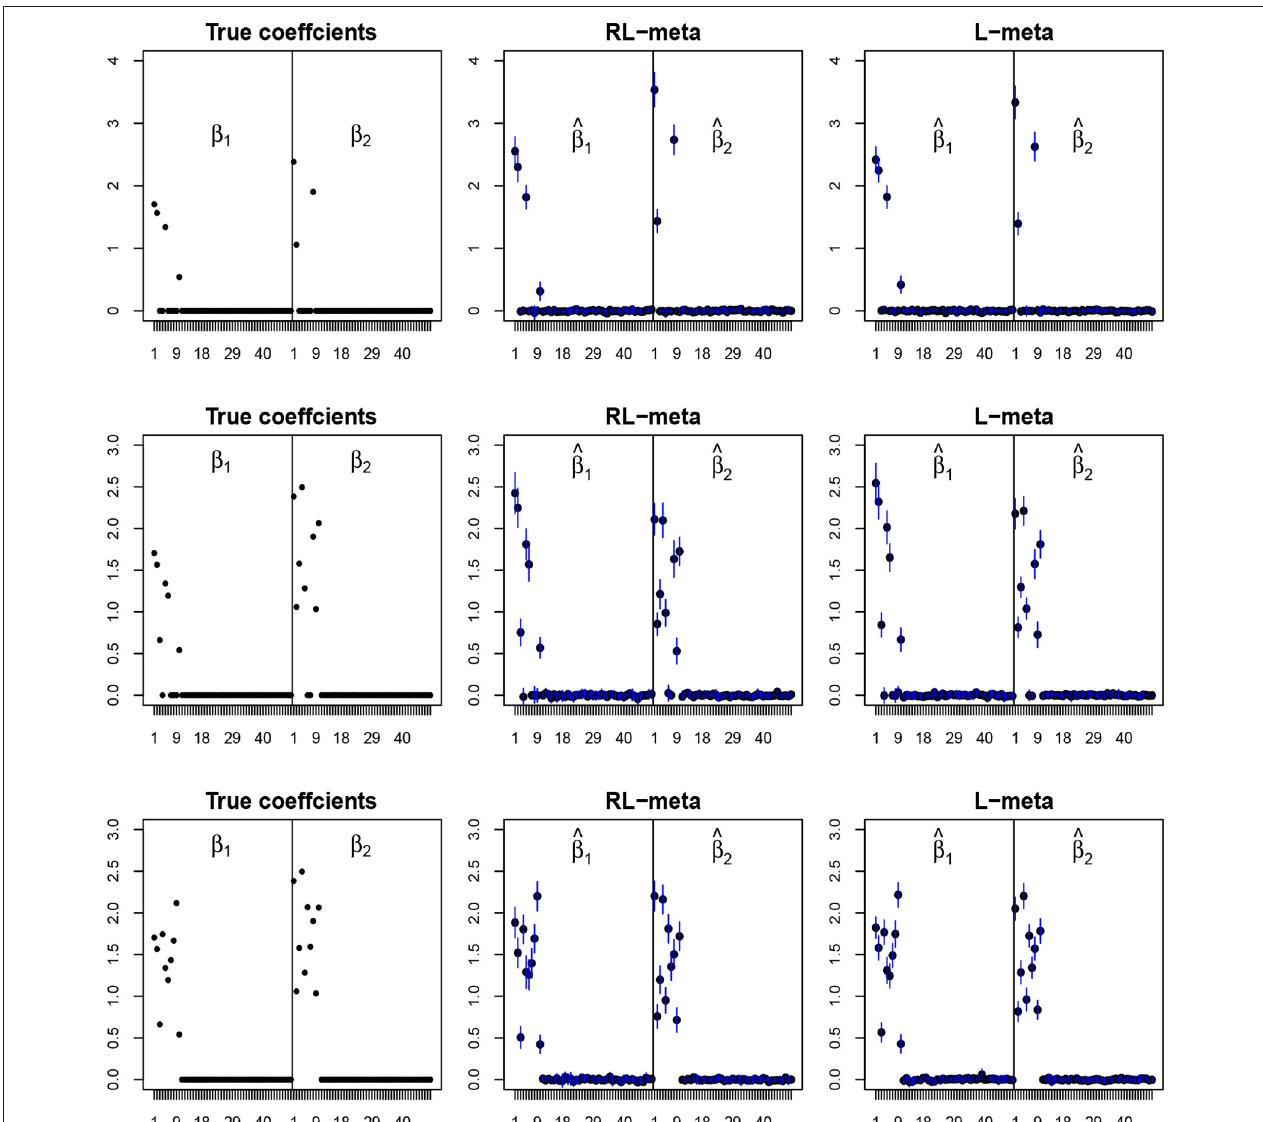
FIGURE 2 | The coefficient estimates with clean data for M = 2 and ( n , p ) = (100,50). The blue points and lines represent the mean values and the interval estimates of coefficients over 100 simulations. Rows from top to bottom correspond to π 0 = 0.2,0.5,0.9, respectively.